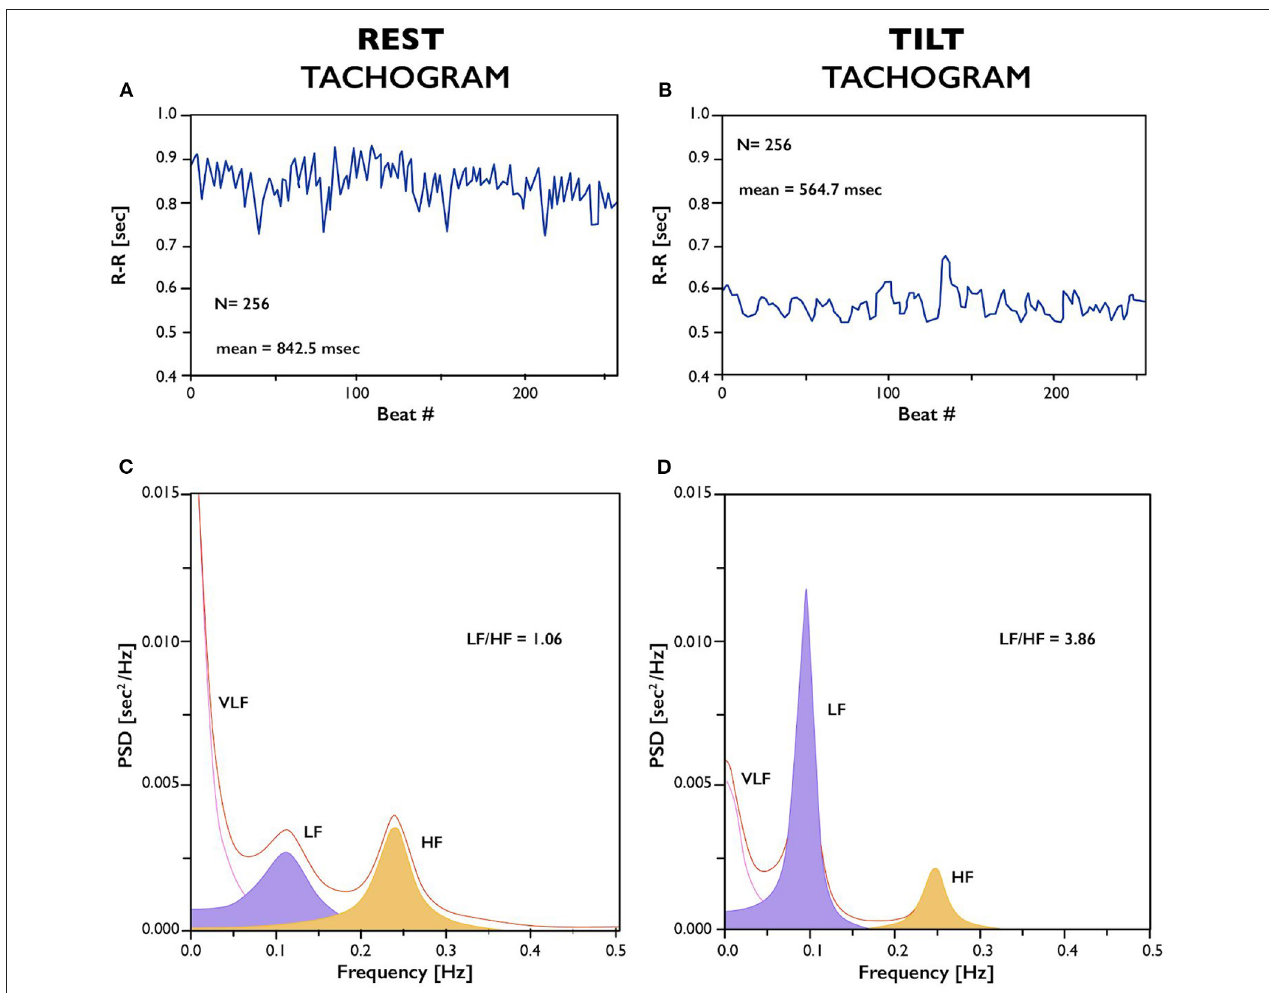
FIGURE 5 | Illustrative example of heart rate variability derivation and how smoothing heart rate data can lead to variability detecting changes in the sympathetic/parasympathetic nervous system. Figure plots are based on data presented in Electrophysiology (1996). (A) shows the raw tachogram fluctuations in heart rate during supine rest and (C) shows the derivative power spectral density (PSD) of the supine rest heart rate data to calculate the VLF, LF, and HF frequency bands that can be used to assess autonomic nervous system balance. (B,D) show the raw heart rate tachogram and derived PSD plot after a 90 degree head-up tilt physiological perturbation that increases the sympathetic nervous system response. Smoothing or interpolation algorithms acting on the raw rest tachogram data can potentially generate tachogram data similar to the tilt condition in (B) , leading to a spurious shift in the observed LF/HF ratio. In the context of wearable consumer devices with potential data gaps and heavy-handed closed-source smoothing/interpolation algorithms, it is thereby possible to misinterpret smoothed or interpolated data as a shift in the sympathetic/parasympathetic nervous system responding, even when no such shift has occurred.